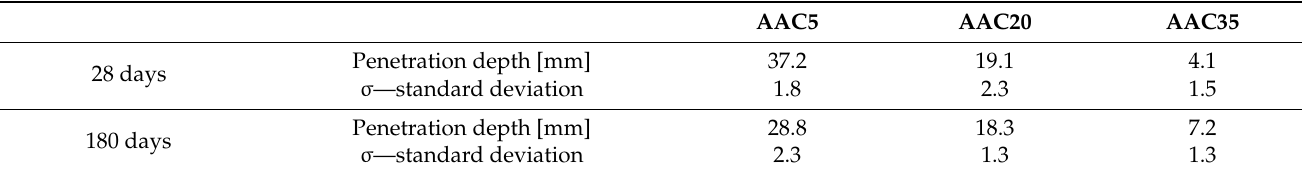
Table 4. The average values and standard deviations of chloride penetration depth of AAC.